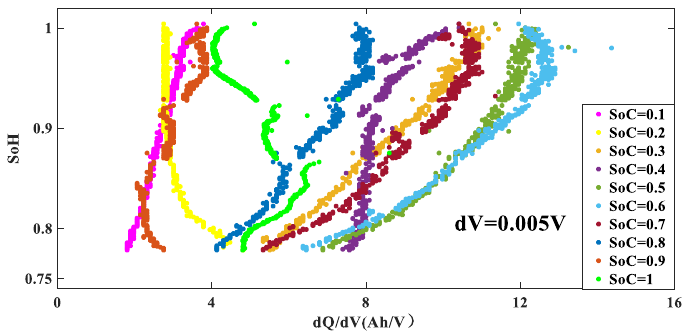
Figure 6. The relationship between dQ / dV and SoH with dV = 0.005 V.